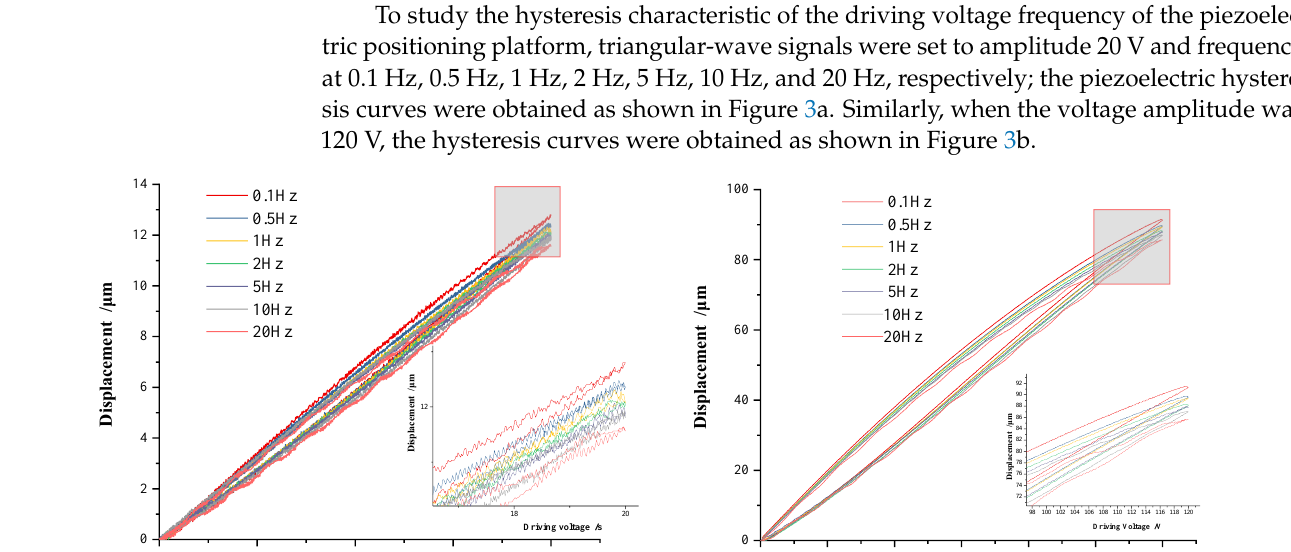
Figure 2. Hysteresis on variable voltage amplitudes (0.1 Hz).